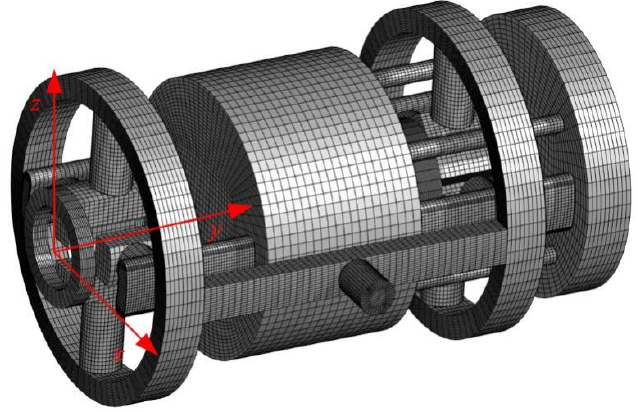
Figure 8. The grid model of the parallel 2D piston pump.